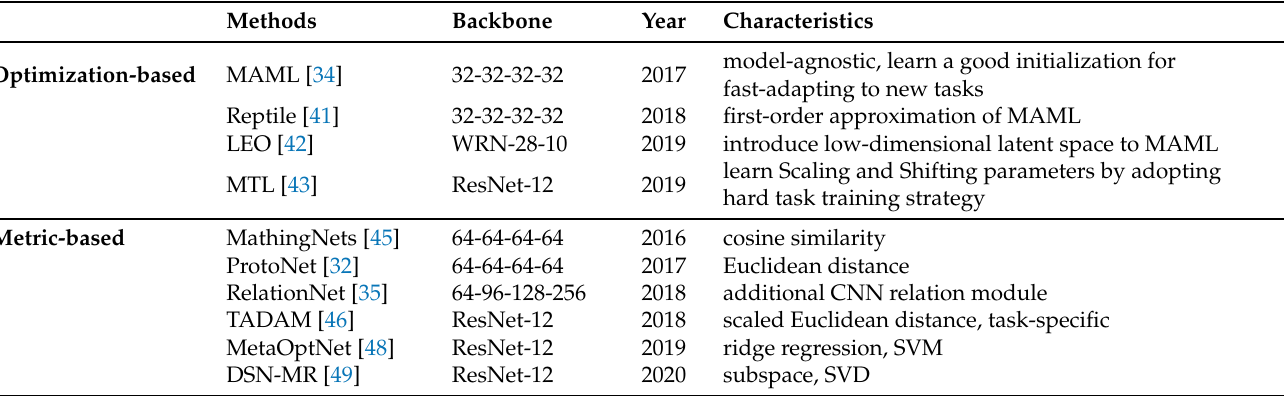
Table A2. Characteristics of few-shot learning methods. a-b-c-d denotes a 4-layer convolutional network with a, b, c, and d filters in each